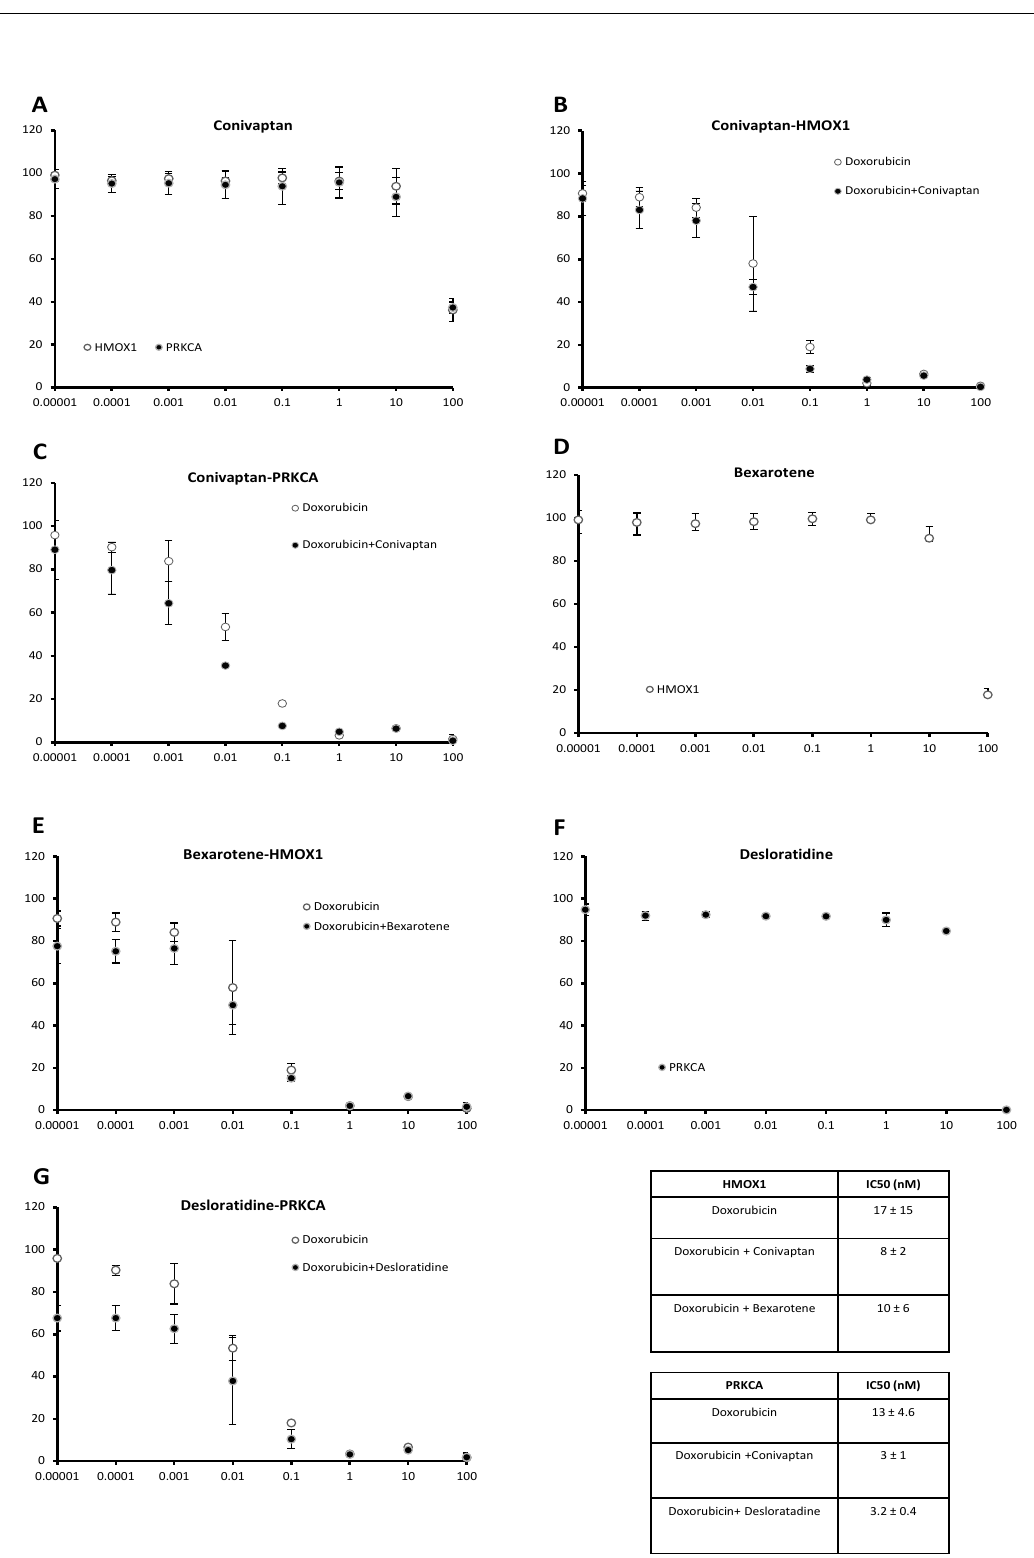
Figure 6. Effect of candidate inhibitors of HMOX1 or PRKCA on doxorubicin cytotoxicity in HMOX1 - or PRKCA -transfected cell lines (cell viability, % of control: y -axis; concentration in µ M: x -axis). ( A ) Conivaptan alone, ( B ) conivaptan with or without doxorubicin in HMOX1 -transfected cells, ( C ) conivaptan with or without doxorubicin in PRKCA -transfected cells, ( D ) bexarotene alone, ( E ) bexarotene with or without doxorubicin in HMOX1 -transfected cells, ( F ) desloratadine alone, and ( G ) desloratadine with or without doxorubicin in PRKCA -transfected